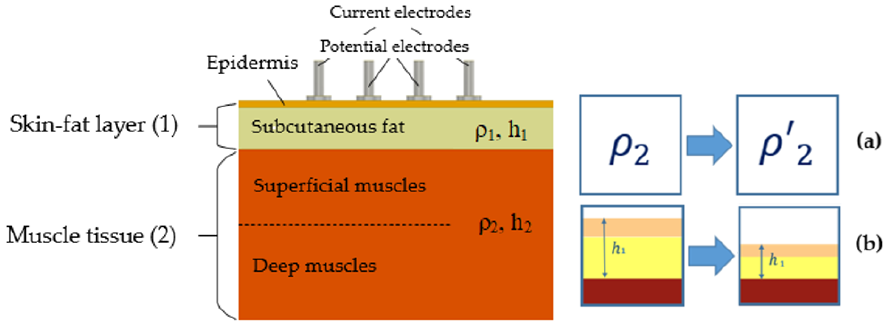
Figure 2. EI myography conditioning mechanisms: ( a ) change in muscle resistivity; ( b ) changes in skin-fat layer thickness (h 1 is the skin-fat layer thickness; h 2 is the muscle tissues thickness; ρ 1 is the skin-fat layer electrical resistivity, ρ 2 is the muscle tissues electrical resistivity).